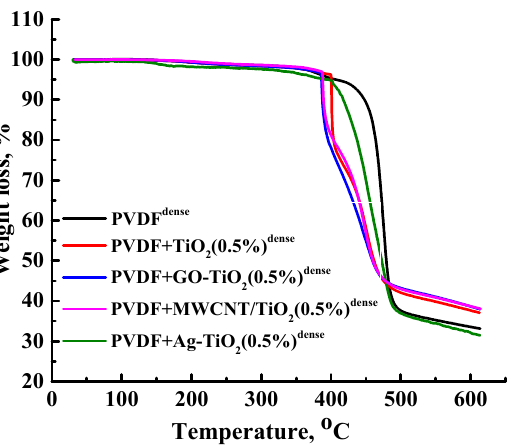
Figure 11. TG curves for dense membranes based on PVDF and its composites with nanoparticles.